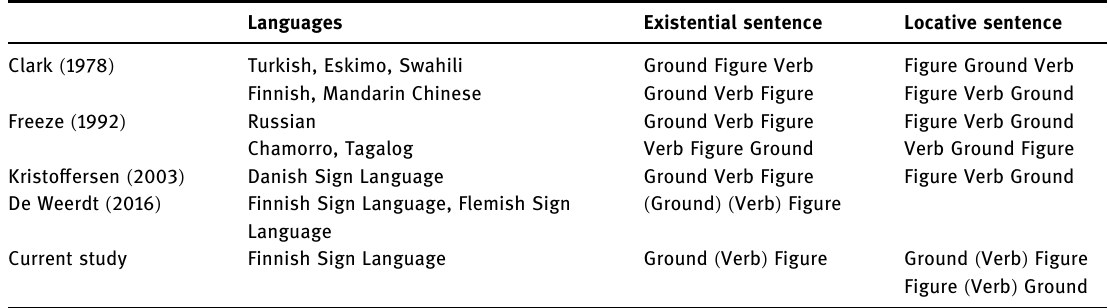
Table 5: An overview of the order of Figure and Ground in existential and locative sentences from both spoken and signed languages